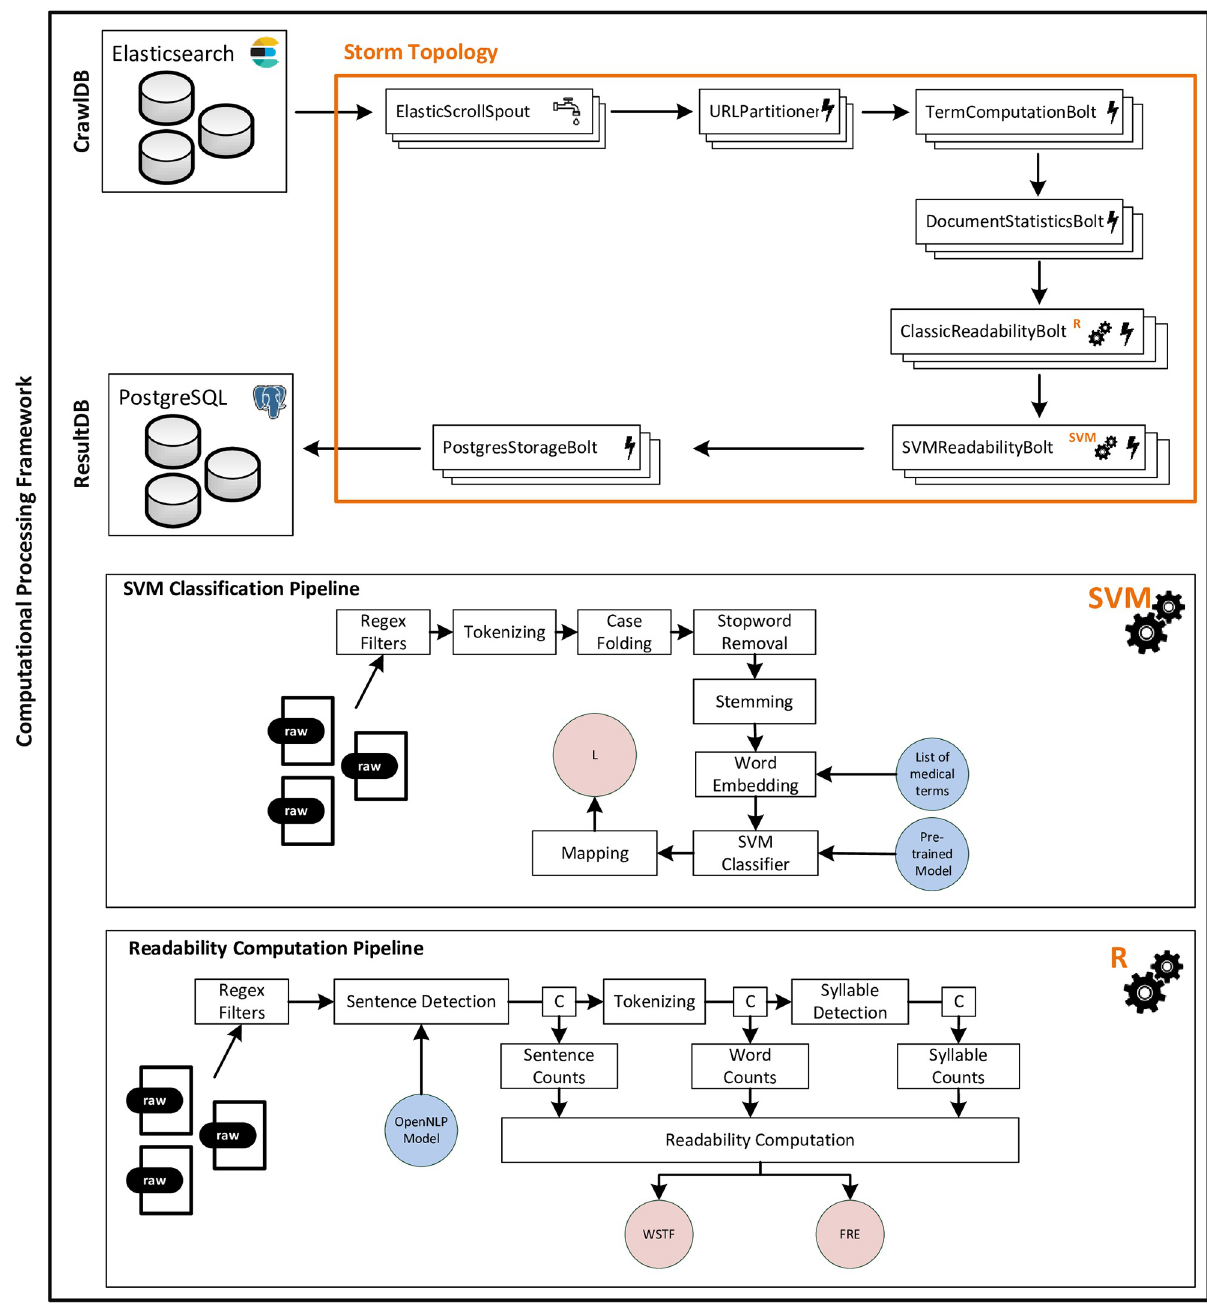
Fig 1. Workflow and architecture of the computational processing framework. Spouts (tap symbol) emit data (here: web pages), bolts (lightning symbol) process data (i.e. term statistics, readability metrics, vocabulary-based text difficulty, storing results). SVM: Support Vector Machine, R: Readability